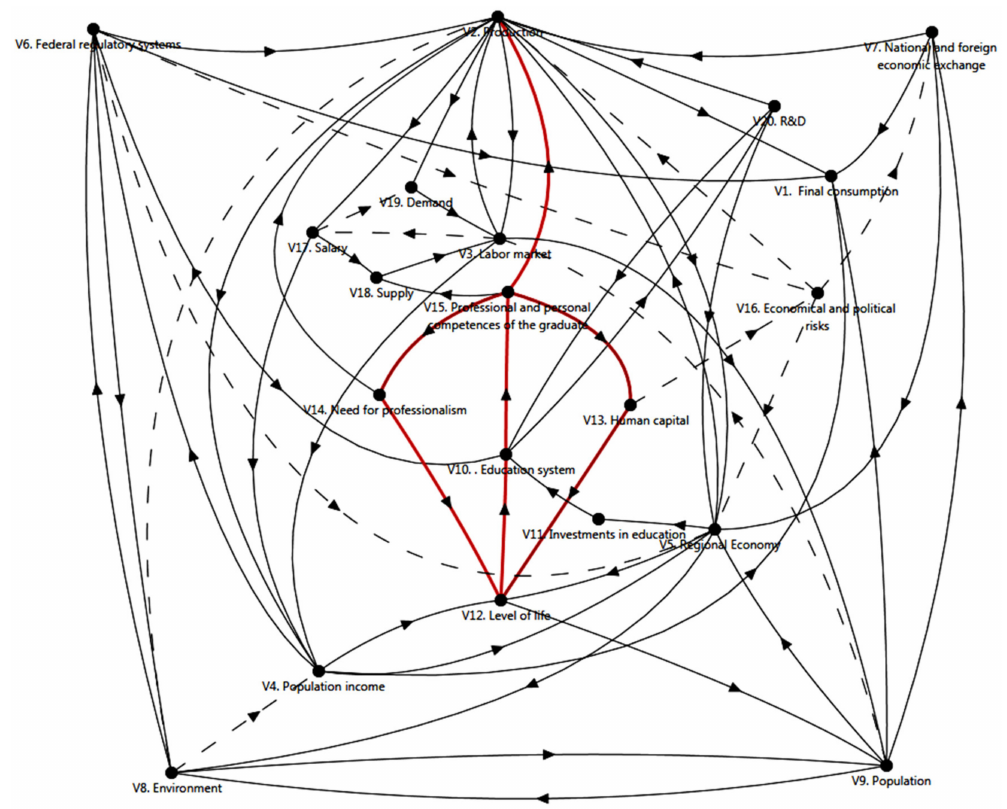
Figure 1. Cognitive model (G) of the relationship between the regional system and the higher education system, taking the needs of the region into